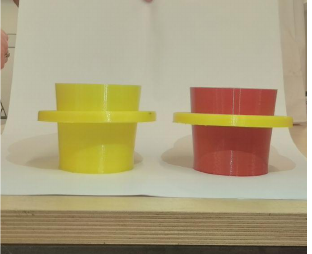
Fig. 1. The first 3D-printed prototype, which allowed us to understand we were after the wrong